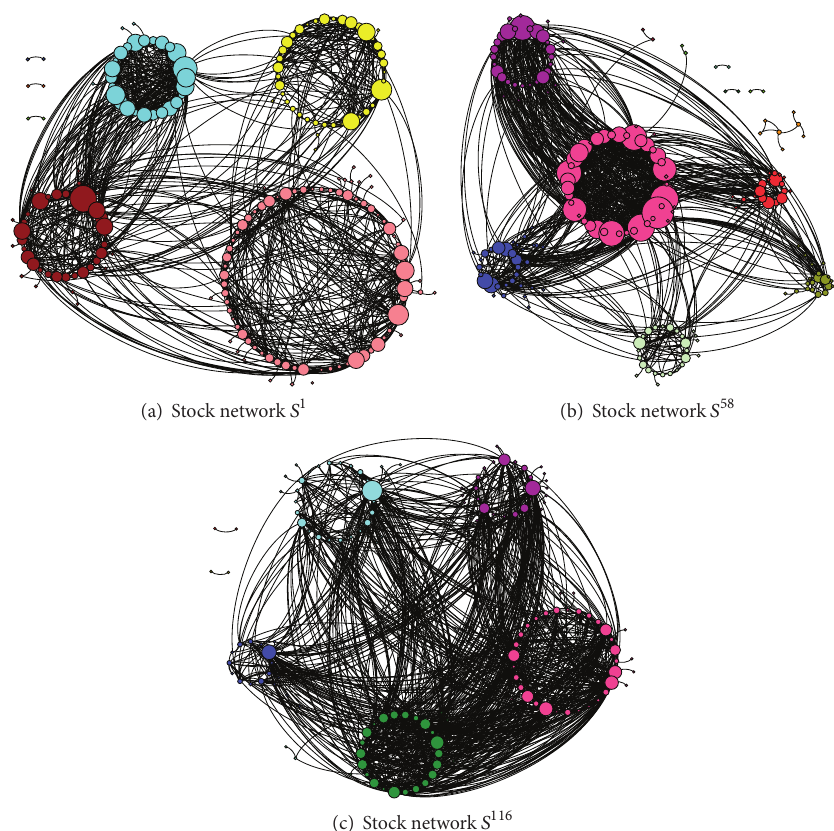
Figure 5: (Color online) Several pictures of stock networks 𝑆 𝑡 . Different node colors represent different communities and node sizes reflect its